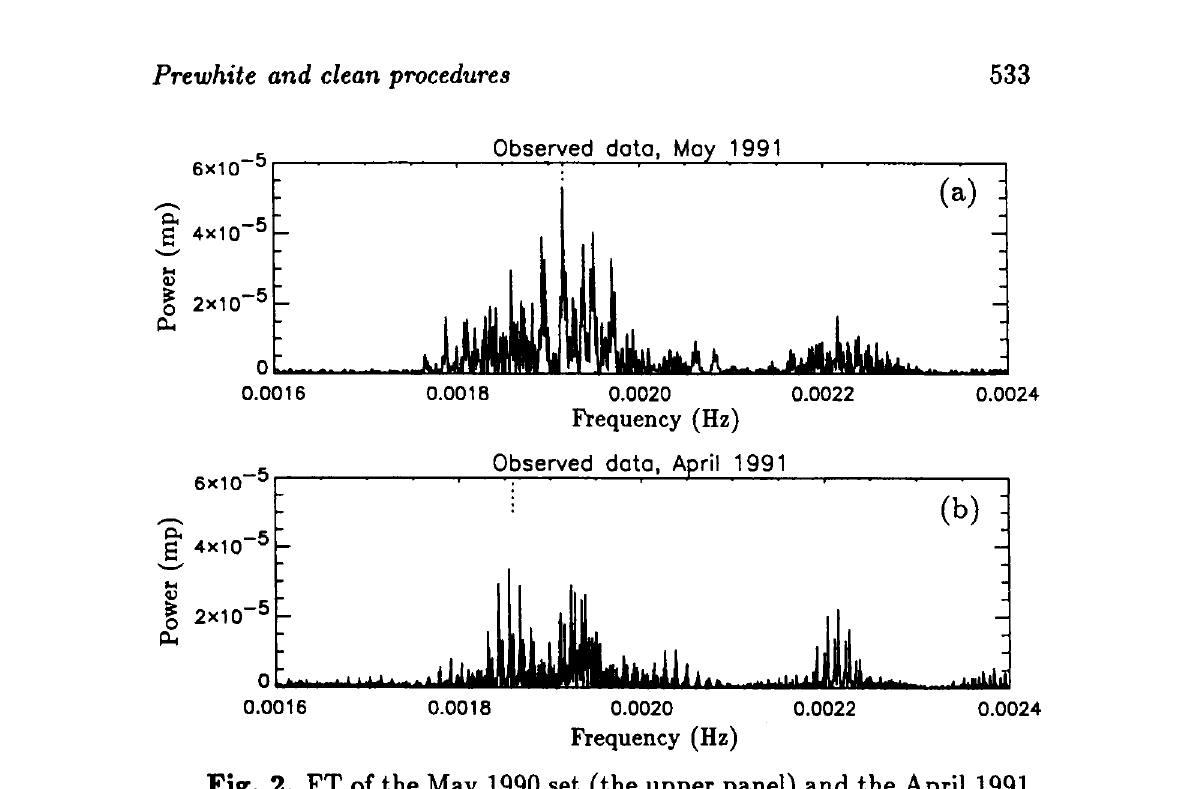
Fig. 2. FT of the May 1990 set (the upper panel) and the April 1991 set (the lower panel). The marked periods are 522 s in the May 1990 data and 538 s in the April 1991